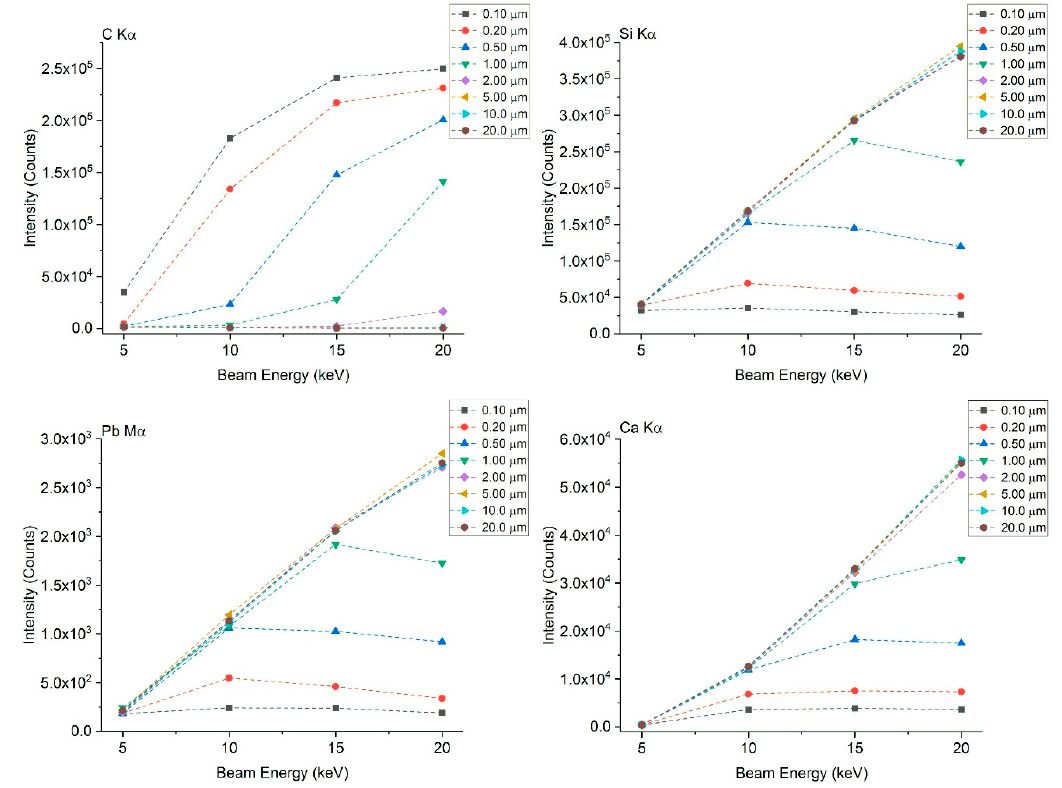
Figure 8. Simulated net X-ray intensities of the C, Si, Ca K α and Pb M α emission lines of a spherical Egyptian blue pigment, for different radii and electron beam energies, on a pure carbon substrate (according to the scheme of Figure 7). The statistical variation for each point is of the order of 1%.